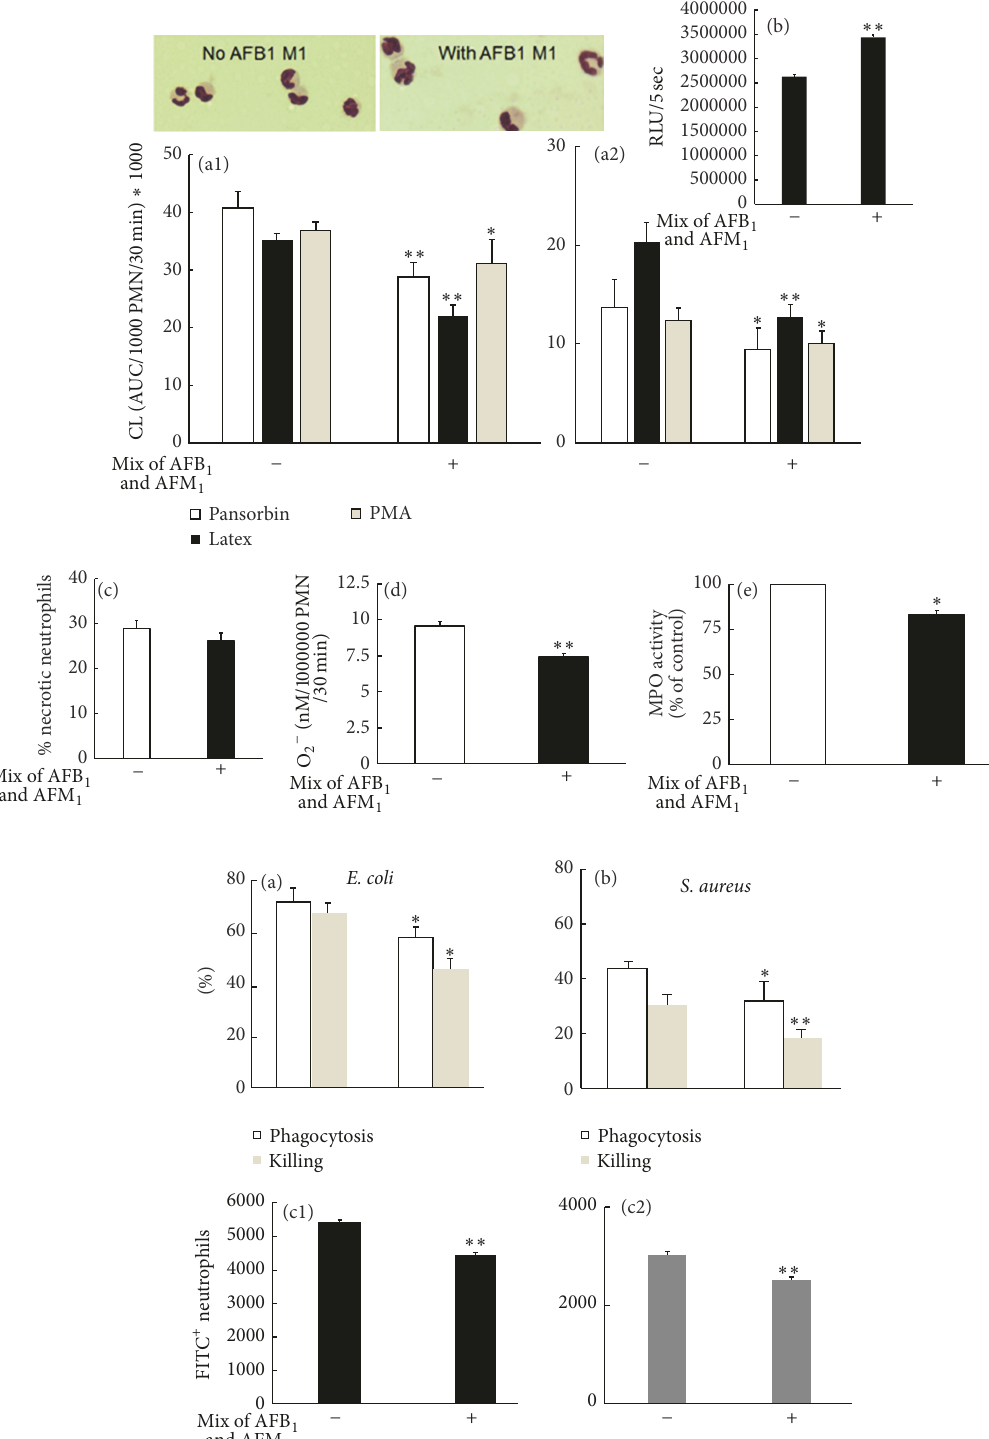
Figure 2: Upper panel, luminol-dependant chemiluminescence (CL) in blood (a1) and milk (a2) neutrophils incubated with(out) 20 ng/ml of mix of aflatoxins (AFs) B 1 and M 1 for 12 h and stimulated with PMA, latex beads, and opsonized Pansorbin; values are expressed as the area under the curve (AUC) of relative light units (RLU)/s of 1000 viable neutrophils during 30 minutes. The inserted images representatively confirm the high purity and similar light microscopic appearance of neutrophils in both groups. Effect of above-mentioned level of mix of AFs on luminol-dependent CL from added hypochlorite (HClO) (b), necrosis (c), O 2− production (d), and myeloperoxidase (MPO) activity (e) in neutrophils. Lower panel, mix of aflatoxins (AFs) B 1 and M 1 weakens phagocytotic activity and killing capacity of blood neutrophils. Effect of 20 ng/ml of mix of AFB 1 and AFM 1 (non)treated for 12h on the phagocytosis and killing activity of neutrophils against E. coli (a), S. aureus (b), and phagocytosis of 1 𝜇 m fluorescent microparticles by blood (c1) and milk (c2) PMN. Values are means ± SEM of 8 ( ∗ 𝑃 < 0.05 ; ∗∗ 𝑃 < 0.01 versus